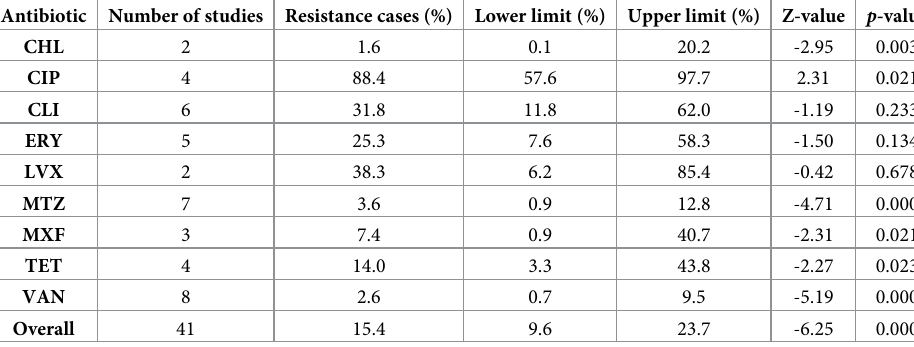
Table 4. The percentages of antibiotics resistance of C . difficile